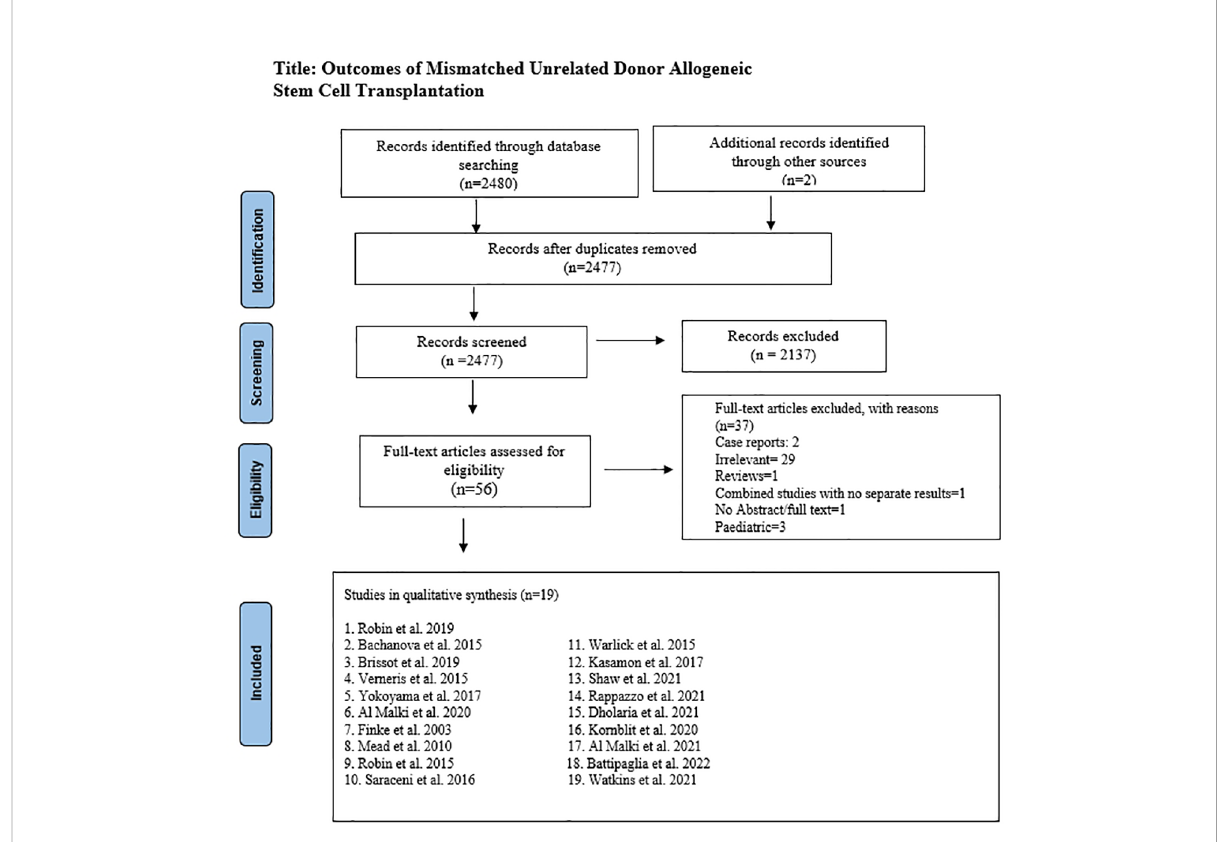
FIGURE 1 PRISMA Diagram for included and excluded